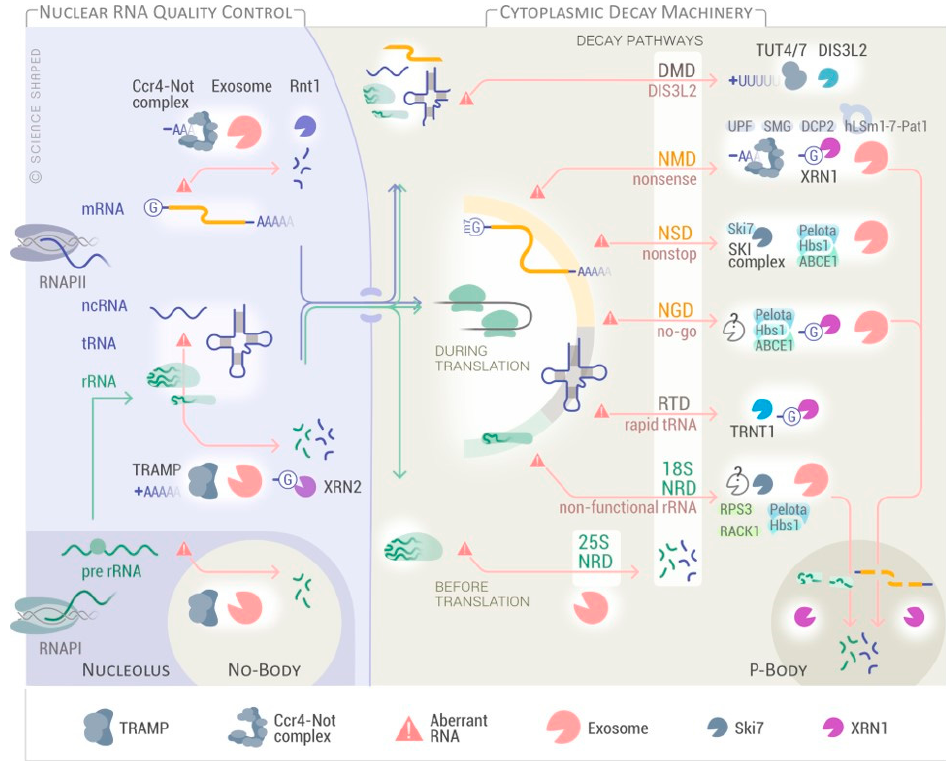
Figure 3. RNA degradation pathways in eukaryotes. RNA quality control mechanisms and their cellular compartments for aberrant mRNA, tRNA, rRNA, and ncRNA in eukaryotic cells are depicted. NMD, nonsense-mediated mRNA decay; NGD, no-go decay; NSD, non-stop decay; NRD, non-functional rRNA decay; RTD, rapid tRNA decay; DMD; DIS3L2-mediated decay.